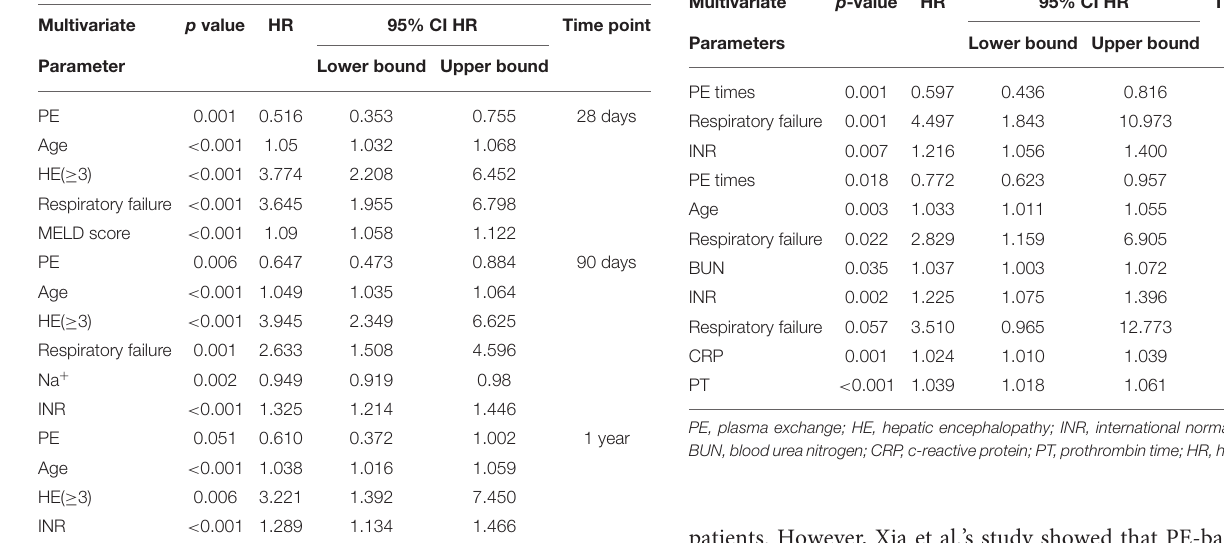
TABLE 4 | Prognostic factors at 28 days, 90 days, and 1 year in HBV-ACLF patients treated with SMT alone or in combination with SMT and PE-based NB-ALSS.